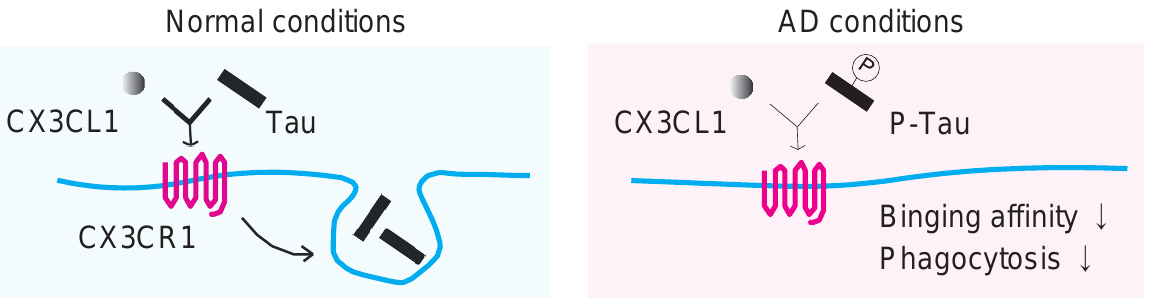
Figure 2. Phagocytosis: The CX3CL1/CX3CR1 axis plays a key role in the phagocytosis of tau by microglia and is affected as AD progresses. S396 Tau phosphorylation decreases the binding affinity of this protein to CX3CR1.